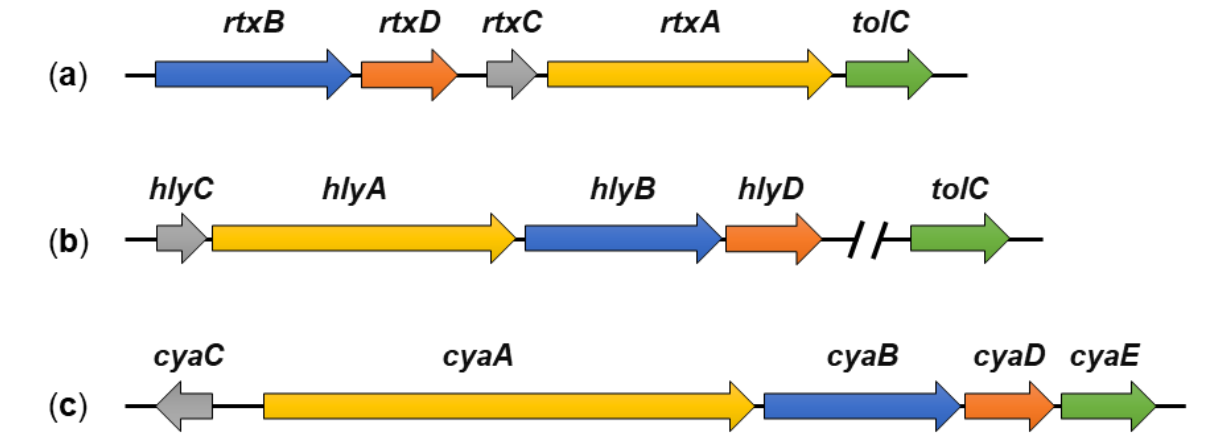
Figure 2. Genetic organization of the rtx loci. The schematic representation of the rtx gene locus of K. kingae strain 269–492 ( a ), E. coli strain CFT073 ( b ), and B. pertussis strain 18323 ( c ). The colored arrows represent coding regions and transcriptional directions of the rtx genes encoding the protoxin proRTXA (yellow), the acyltransferase RTXC (gray), and the proteins of the T1SS apparatus (blue, ABC transporter; orange, MFP; green, OMF).